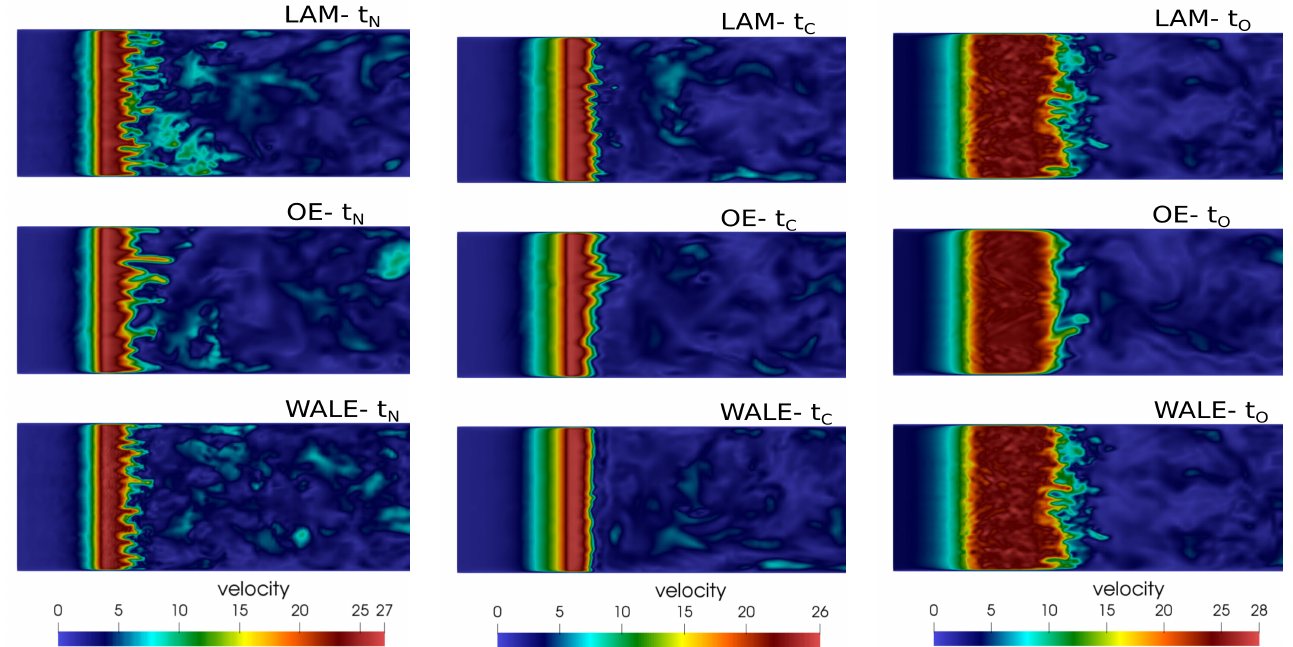
Figure 4. Velocity fields [ms − 1 ] in mid–sagittal plane in three time